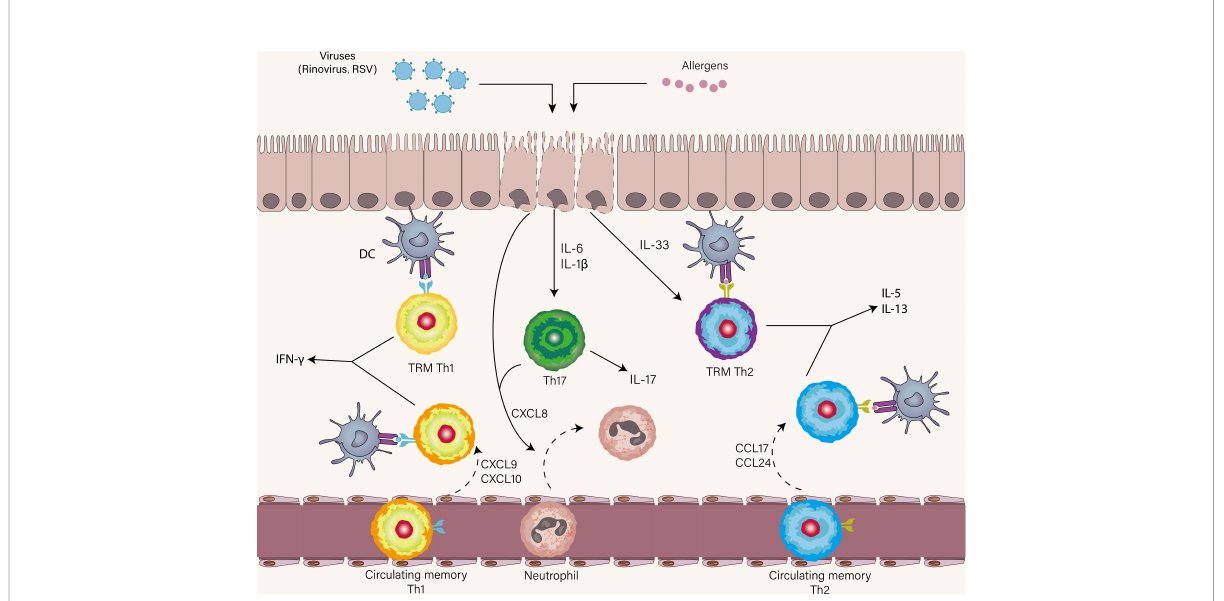
FIGURE 4 The role of Th1, Th2, and Th17 cells in asthma exacerbation. Once encounter respiratory viruses and allergens, airway epithelial cells produce a wide range of cytokines as the fi rst immune responders, most notably IL-33, IL-1 b , IL-6, and CXCL8. Respiratory viral infections mostly elicit a Th1 immune response and less commonly trigger a Th17 immune response. TRM Th2 cells are fi rst reactivated in the presence of IL-33 and cognate antigen. Subsequently, circulating memory Th2 cells are recruited to the lung. A similar scenario also occurs in virus-speci fi c Th1 immune response. IL-1 b and IL-6 promote Th17 cell differentiation and CXCL8 derived from Th17 cells and epithelial cells induce neutrophil recruitment to the